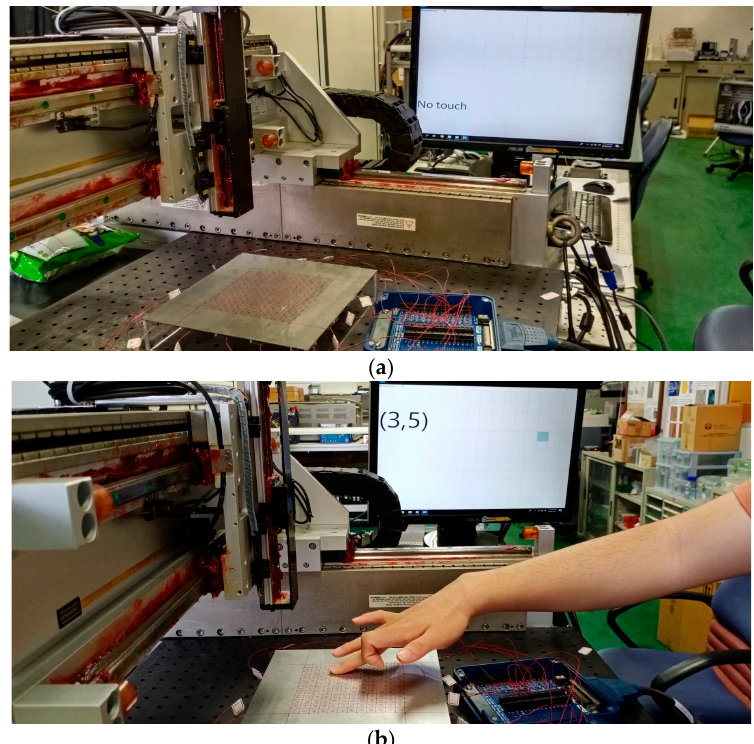
Figure 13. Photos of human-finger testing on the Lamb-wave ultrasound touchscreen when there is ( a ) no touch and ( b ) finger touch at the position coordinates of (3, 5) on the steel plate.